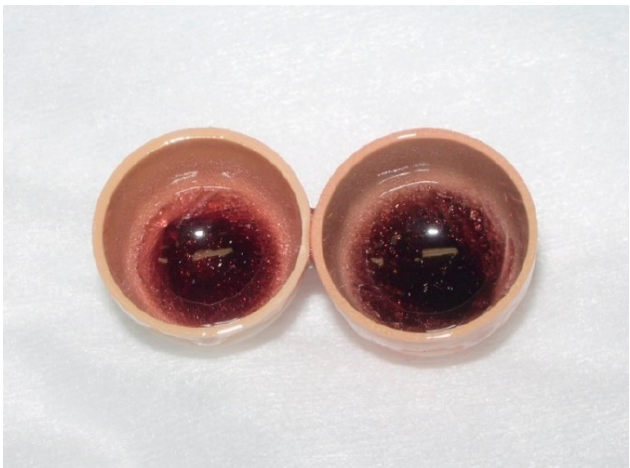
Figure 3. Alumina crucibles with highly radioactive aluminophosphate glass «Na-Al-P_238» doped with 0.15 wt.% (left crucible) and 0.43 wt.% (right crucible) 238 Pu.